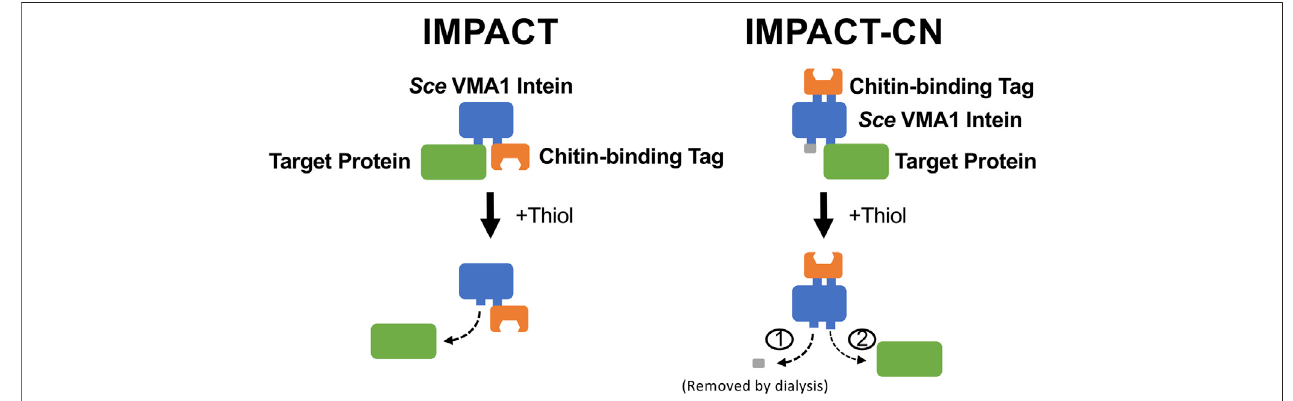
FIGURE 3 | Schematics of the IMPACT and IMPACT-CN systems developed by New England Biolabs (Chong et al., 1998; Wood & Camarero, 2014). One-step puri fi cationofataglesstargetproteinbyaself-cleavingchitin-bindingdomaintagisenabledbyamodi fi ed Saccharomycescerevisiae VMA1inteinintheIMPACTsystem (Combet al.,1998;PatentNo.: US5834247A;givenpriorityin1992,issued in1998andexpiredin2012). N-terminal inteincleavagewasinducedbyaddition of30 mM DTT (thiol) at pH 7.6 and 4 ° C and required an incubation period of 16 h. The IMPACT-CN system allows for either N- or C-terminal cleavage, with an extra dialysis step required forC-terminalcleavage (Comb et al., 1998;Patent No:US 5834247 A; given priority in1992, issued in 1998and expired in2012), showed thatseparation andpuri fi cationoftargetproteinscanbeimprovedbyinsertingtheaf fi nitytagintoamodi fi ed Sce VMA1intein.Inpractice,bothN-andC-terminalcleavagereactionsare induced while the fusion protein is immobilized on the column, and the small N-terminal segment is later removed by dialysis.